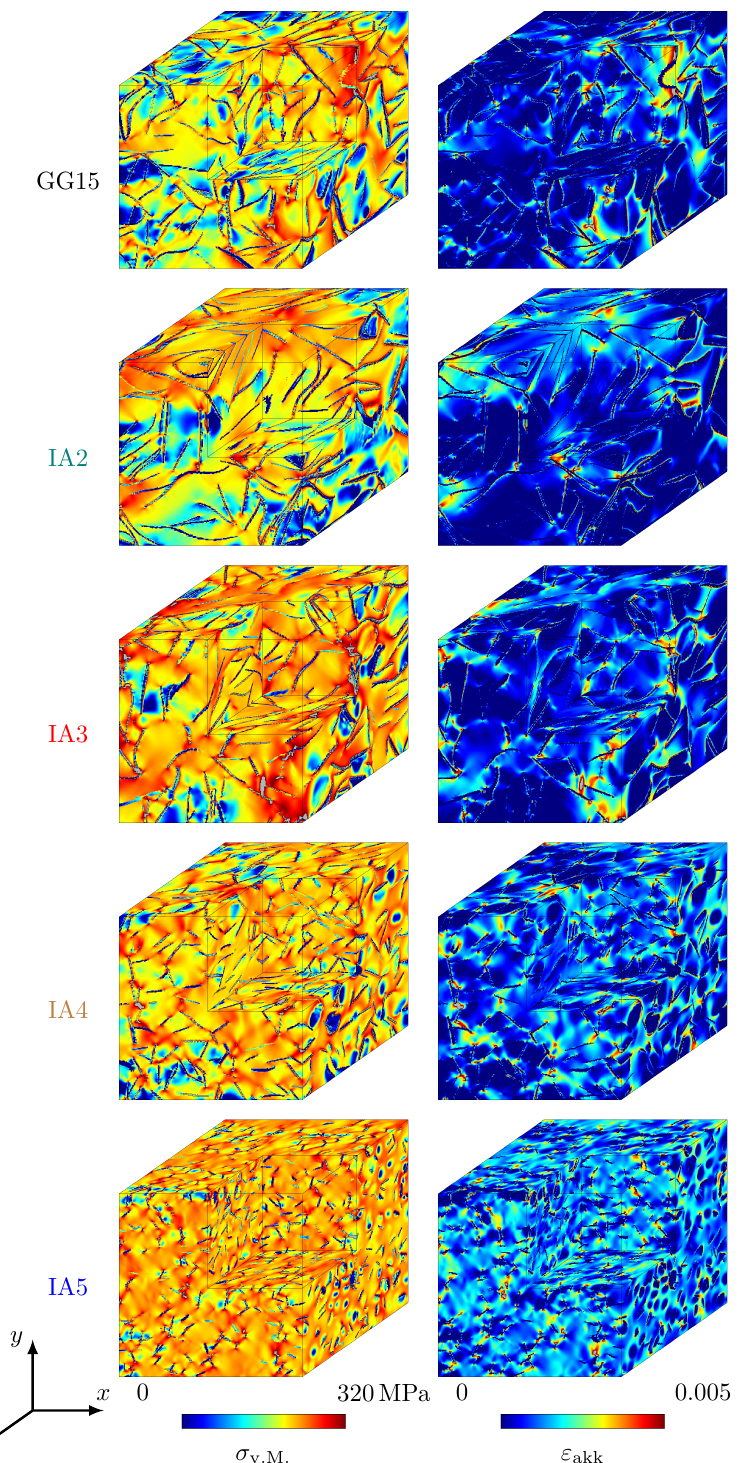
Figure 14. Contour plots for tensile loading of different statistical volume elements with a graphite flake volume fraction of 10v. %. The von Mises equivalent stress, σ v.M. , and the accumulated plastic − strain, ε akk , are shown, at a macroscopic tensile strain of ε = 0.0035 in the x